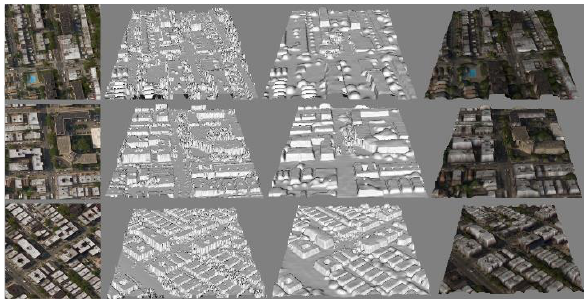
Figure 7. Qualitative example of 3D reconstruction on Potsdam dataset. From left to right: Aerial image, Ground truth